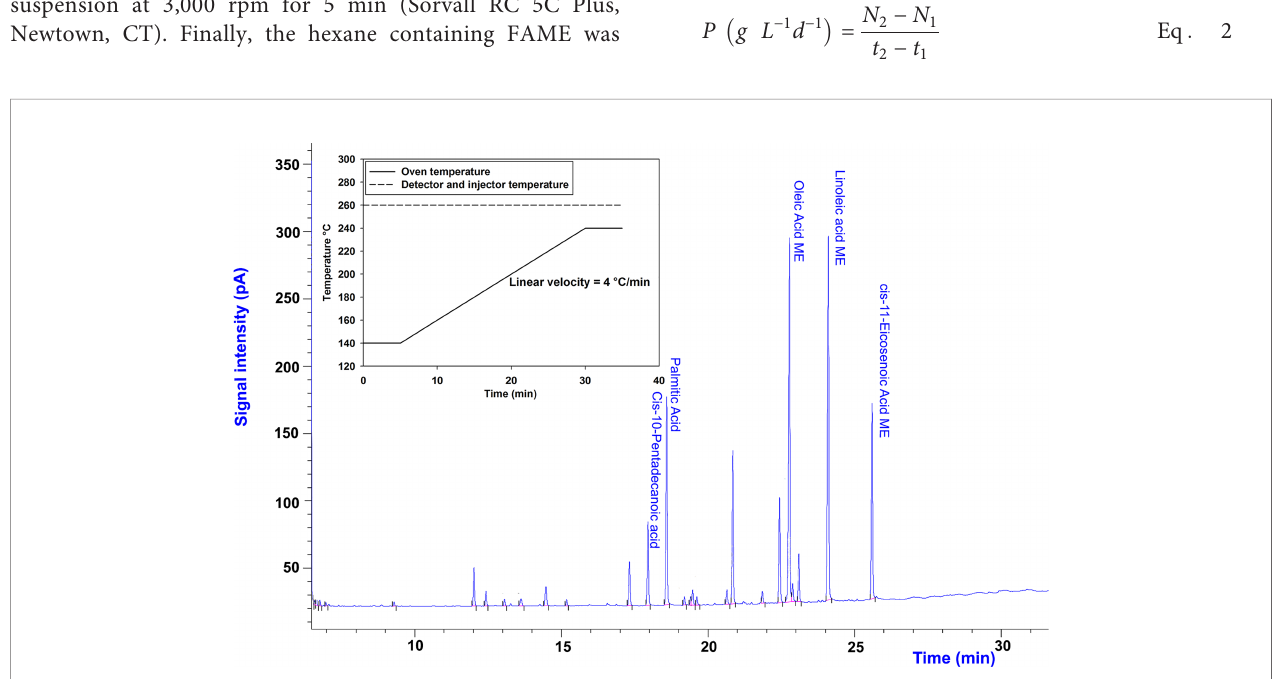
FIGURE 1 | Temperature programing (inset) and GC-FID chromatogram of C. vulgaris on the 25th day of cultivation to obtain the GC-FID pro fi ling of